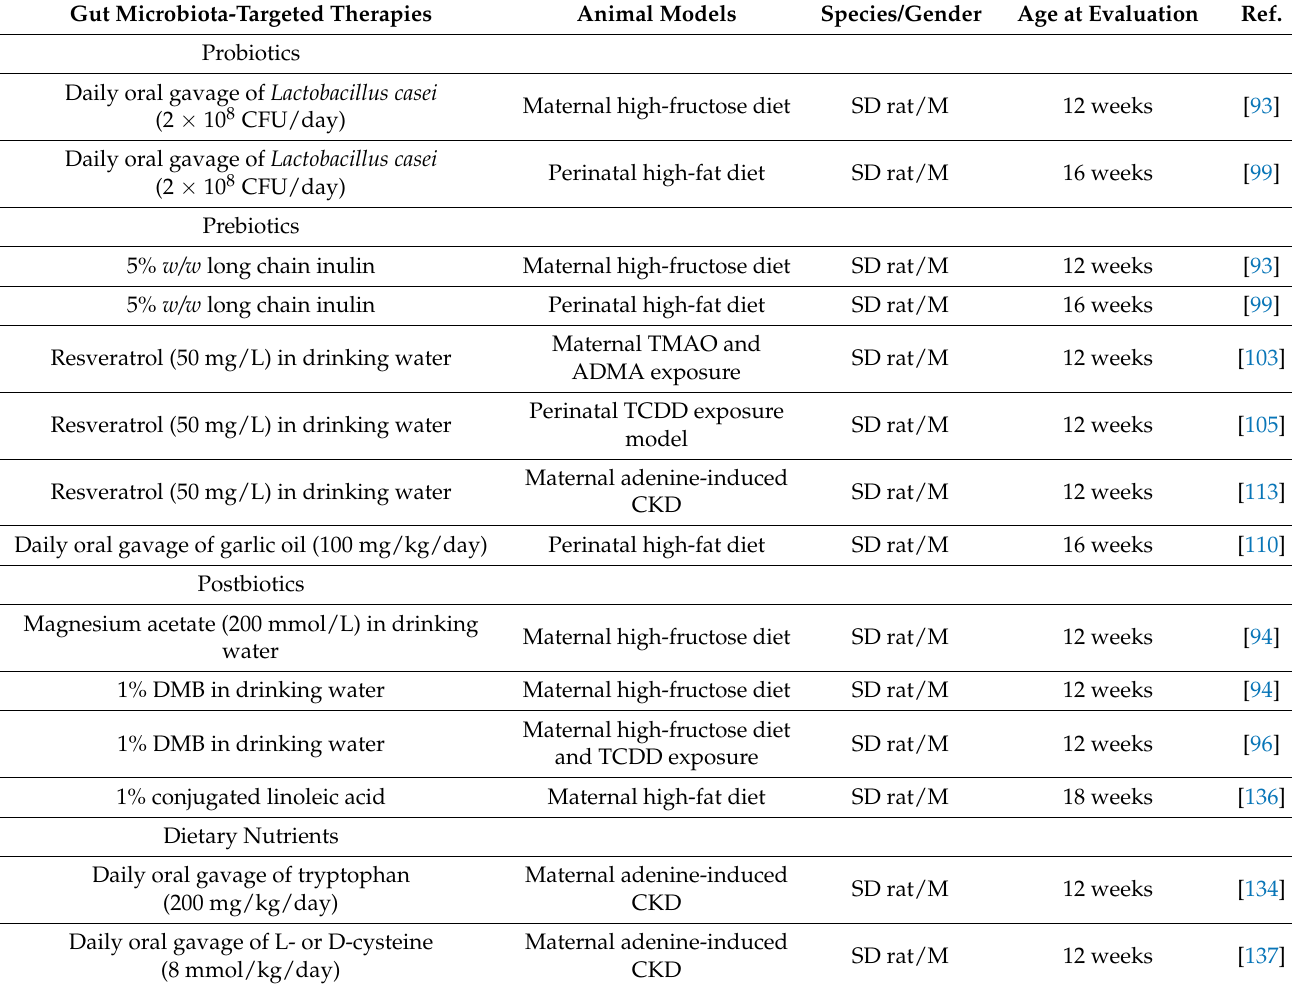
Table 2. Summary of animal models documenting gut microbiota-targeted therapies for hypertension of developmental